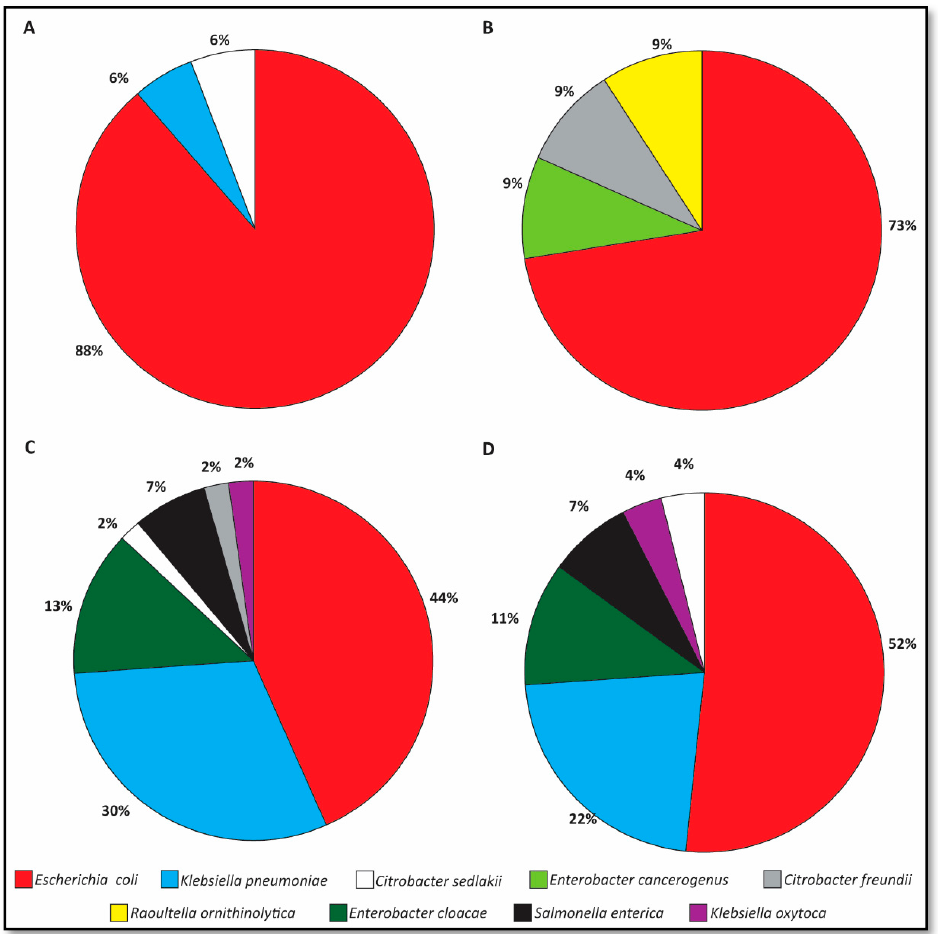
Figure 1. Species distribution of ESBL-E shedding on admission; foals ( A , n = 18 isolates) and mares ( B , n = 12 isolates); and 72 h post admission, foals ( C , n = 46 isolates) and mares ( D , n = 27 isolates).